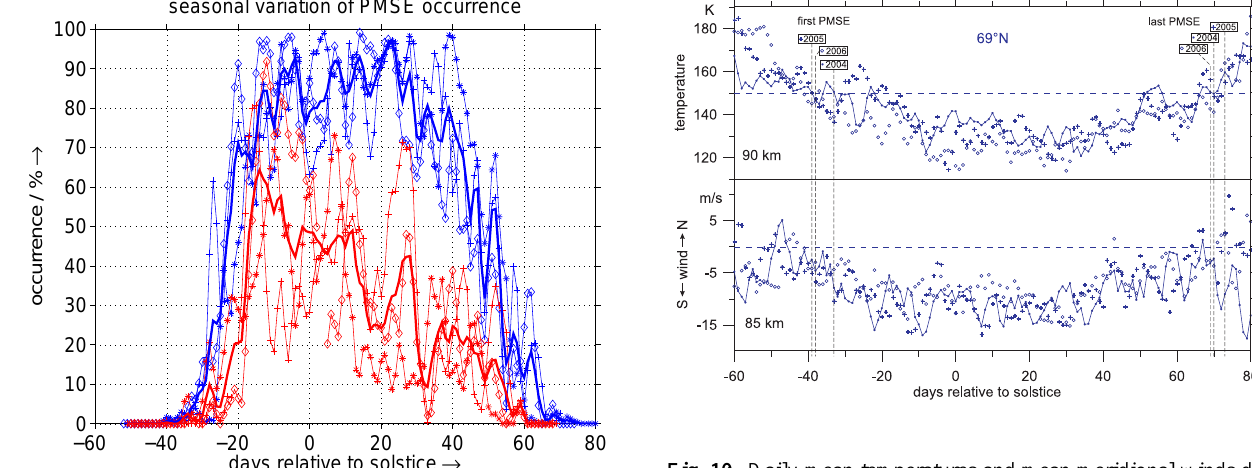
Fig. 10. Daily mean temperatures and mean meridional winds de- rived from meteor radar observations at Andenes for the summers 2004, 2005, and 2006. The appearance of the first and last PMSE events in these years is indicated by the dashed vertical